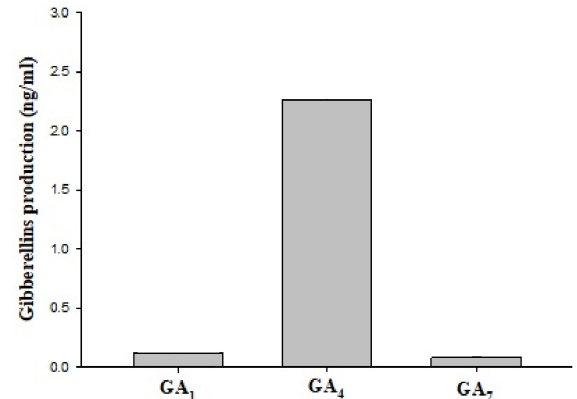
Fig. 3: Bioactive GAs detected in the CF of Bacillus subtilis JW1.